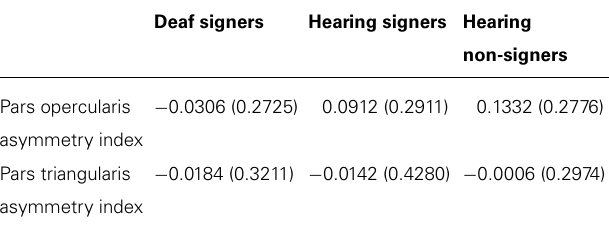
Table 3 |Asymmetry index scores for the pars opercularis and pars triangularis.